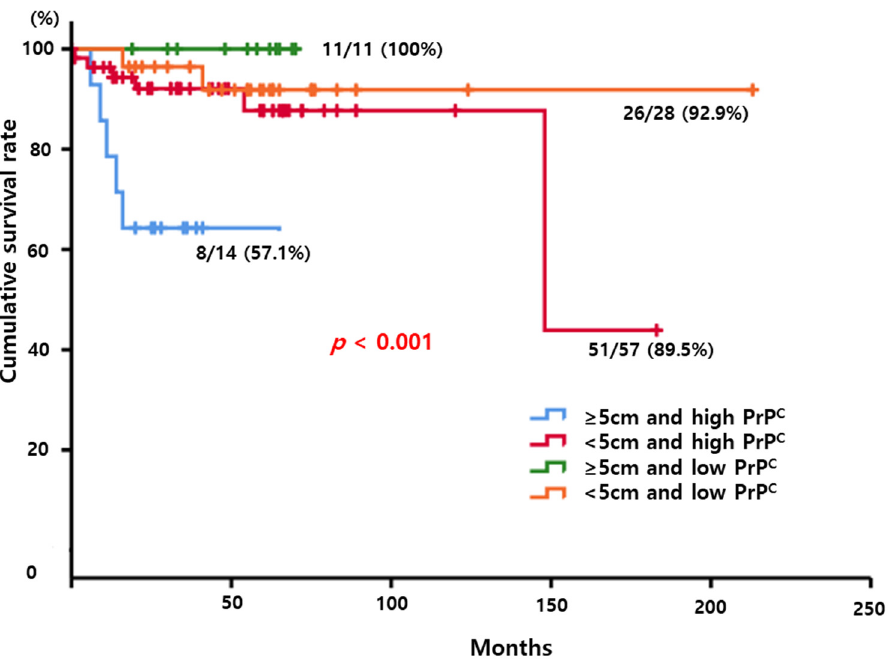
Figure 3. Kaplan–Meier curve to compare the cumulative survival rate according to four combinations between tumor size and PrP C expression. HCC patients with larger tumor and high PrP C expression had poor cumulative survival ( p < 0.001).